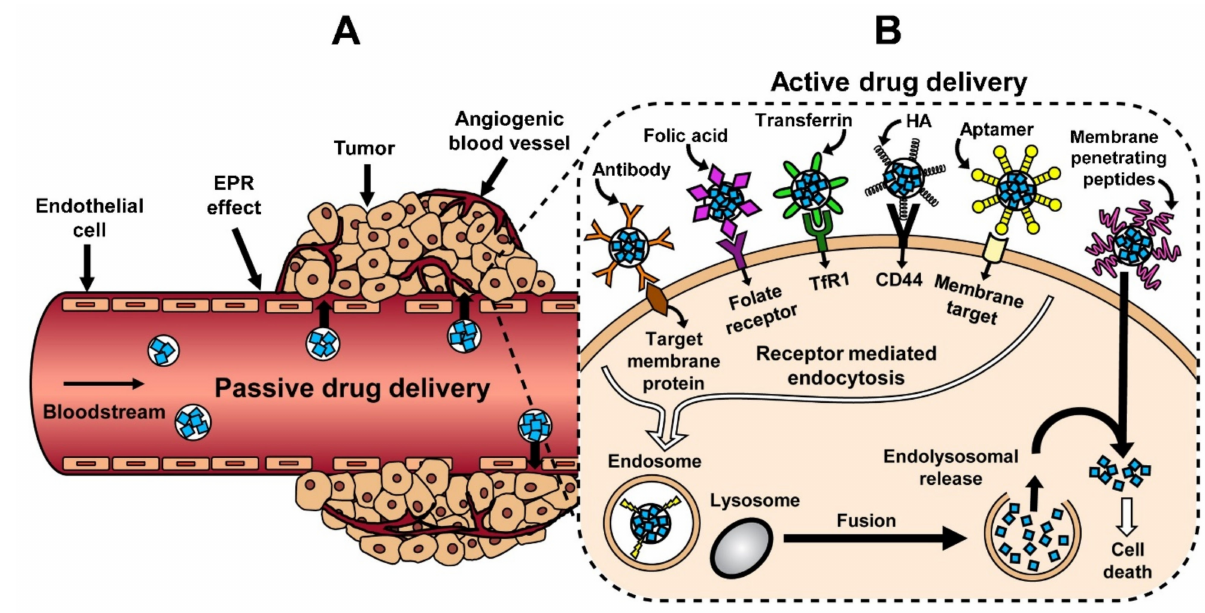
Figure 4. Drug targeting strategies: ( A ) passive drug delivery by the enhanced permeation and retention (EPR) effect and ( B ) active drug delivery mechanisms